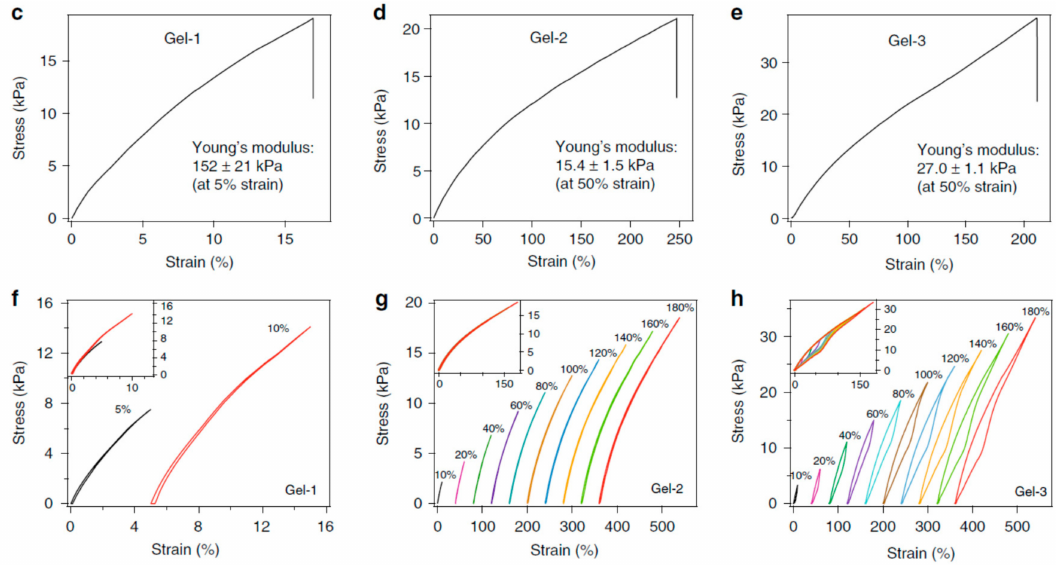
Figure 6. The bulk mechanical properties of the designed hydrogels: ( a ) General procedure for preparation of protein hydrogel rings for mechanical testing. All protein gels were cross-linked using TIP-1:Kir complexes. (GB1)8, (GB1-HP67)4 and SH3 were used as the LBMs and the corresponding hydrogels were denoted as Gel-1, Gel-2 and Gel-3, respectively; ( b ) Setup for the mechanical tests of ring-shaped hydrogel. Stress-strain curves for the Gel-1, Gel-2 and Gel-3 until their breakage ( c – e ). Representative stretching-relaxation curves for the Gel-1, Gel-2 and Gel-3 ( f – h ). The curves are horizontally o ff set for clarity. The final strains are shown on the curves. Insets show the superposition of the stretching-relaxation curves at di ff erent strains [178]. The figure is reproduced from an